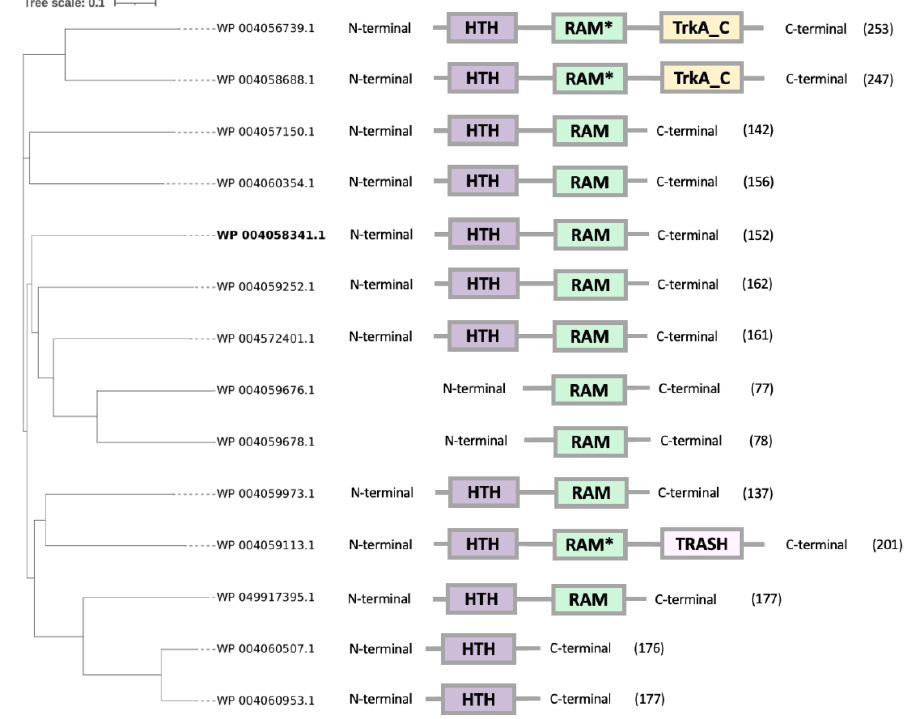
Figure 1. Phylogenetic tree with 14 sequences of Lrps from Hfx. mediterranei and their Protein domain structure. In bold the Lrp protein of interest in this study; in parenthesis the number of amino acids residues; in purple the DNA-binding domain (HTH); in green the ligand-binding domain (RAM); in yellow the TrkA_C domain; and in pink the TRASH domain. Asterisks indicate lower similarity with the query RAM domain PF01037 from